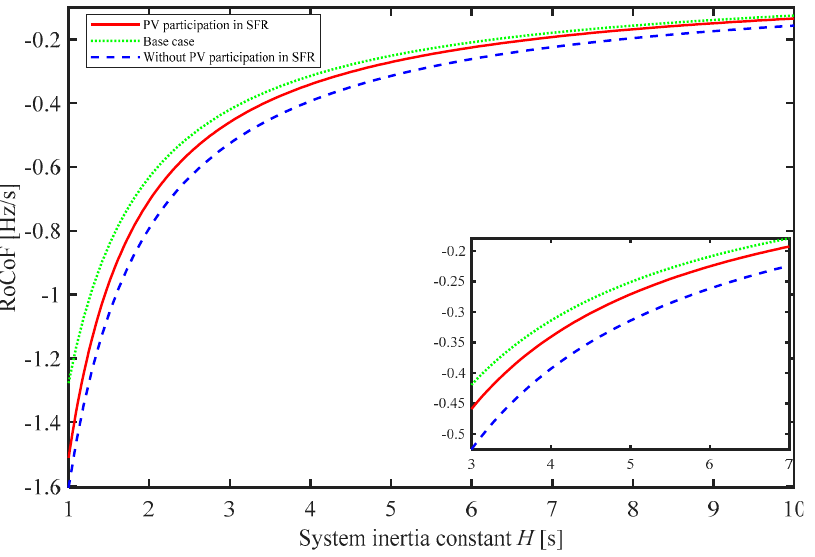
Figure 14. ROCOF analysis regarding the calculated required minimum PV power